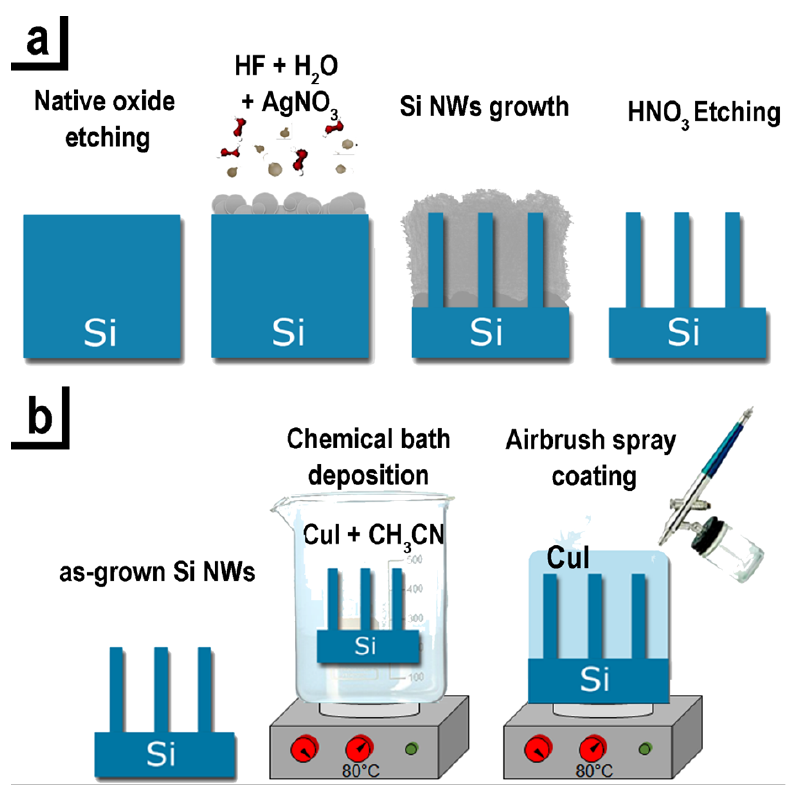
Figure 1. Schematic of Si NWs/CuI heterostructures realization: ( a ) Synthesis of Si NWs by AgNO